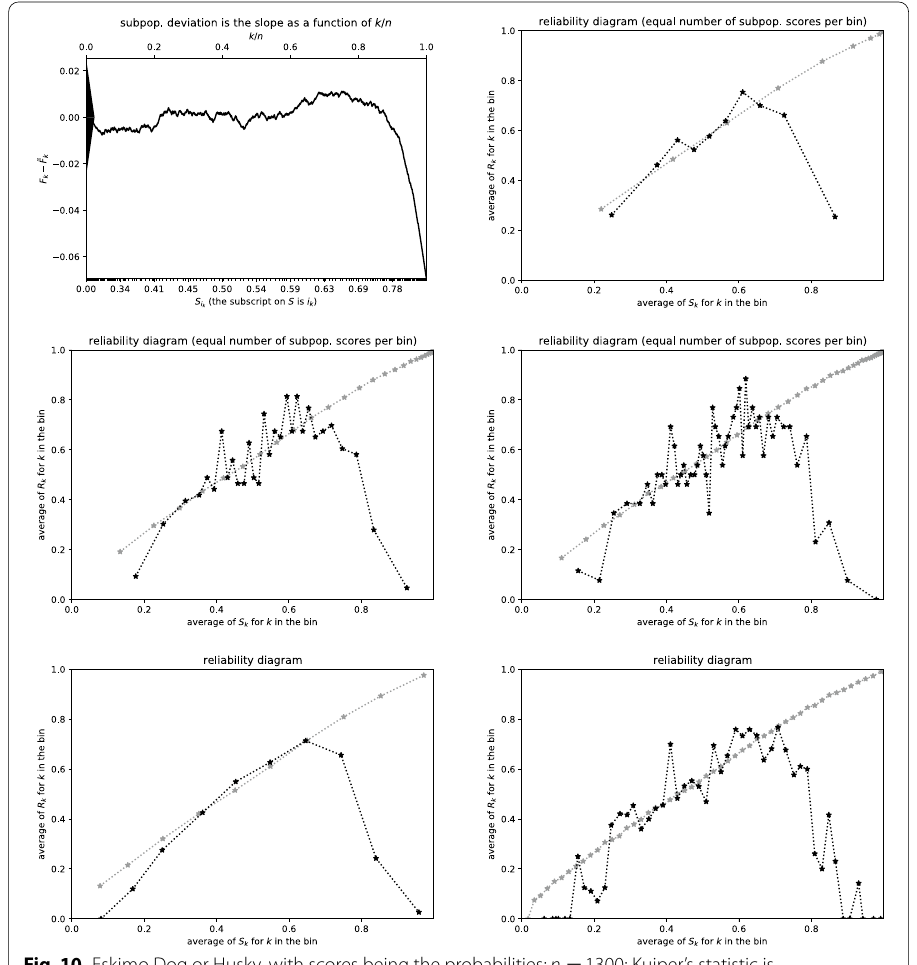
Fig. 10 Eskimo Dog or Husky, with scores being the probabilities; n = 1300; Kuiper’s statistic is 0.08082 /σ = 6.363 , Kolmogorov’s and Smirnov’s is 0.06959 /σ = 5.478 . As in Fig. 9, none of the reliability diagrams with the same number of subpopulation scores per bin is able to smooth away the irrelevant variations while simultaneously capturing the severe deviation at the highest probabilities (however, the reliability diagram with 10 bins that are equispaced in probabilities captures everything nicely). The scalar summary statistics very successfully detect the statistically highly significant deviation of the subpopulation from the full